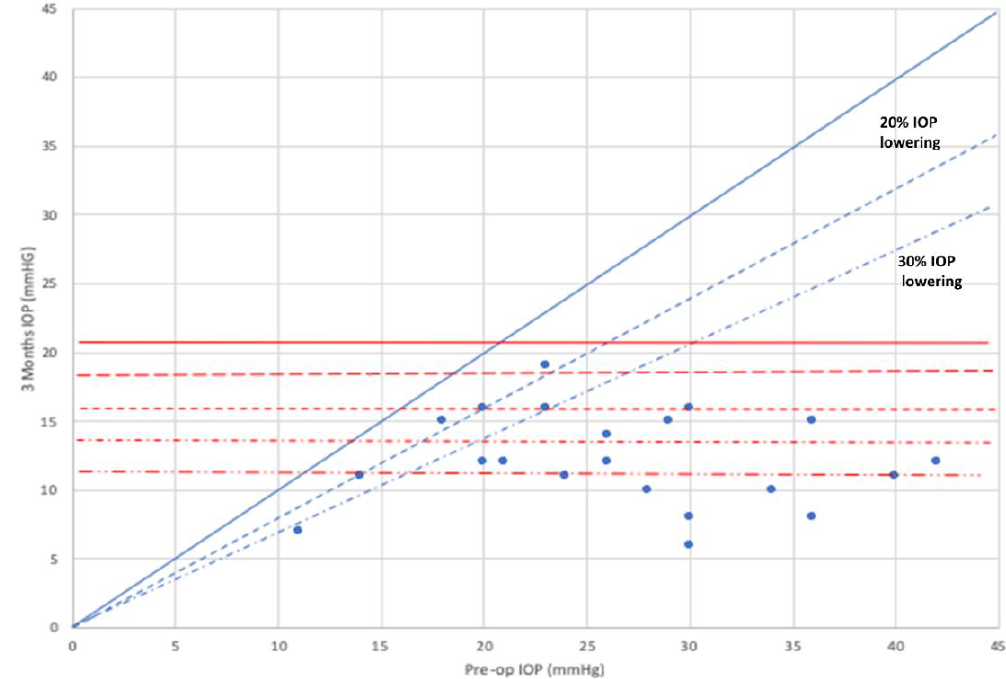
Figure 2. Scatter plot of the intraocular pressure at baseline and month 3. Mean difference − 14.8 ± 6.0 mm Hg, 95 Confidence interval − 18.4 to − 11.2 mm Hg; p < 0.0001 (two-tailed paired-samples Student t test). The 20% and the 30% lines indicate the level beneath which an IOP reduction of more than 20% or 30%, respectively, compared to baseline value before surgery was reached by the individual cases. IOP: Intraocular